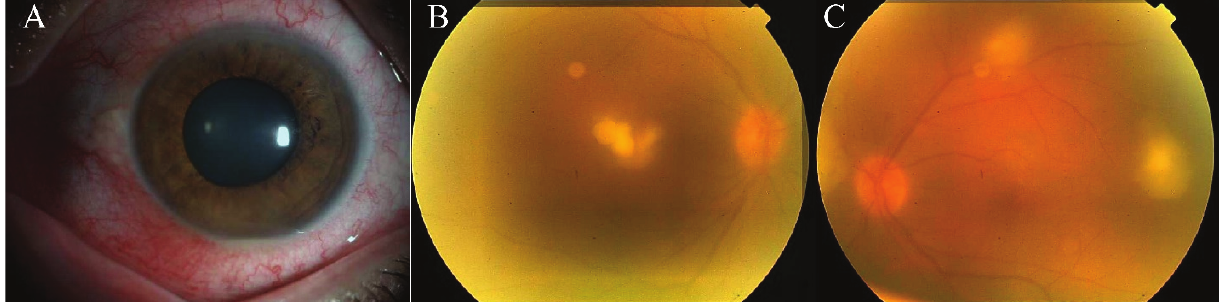
Figure 1. Slit photo of the left eye demonstrating minimal conjunctival injection despite the formation of the hypopyon in the anterior chamber (A). Fundus photo of both eyes showing multiple fluffy pre-retinal yellowish lesions with the involvement of the macular in the right eye (B & C).